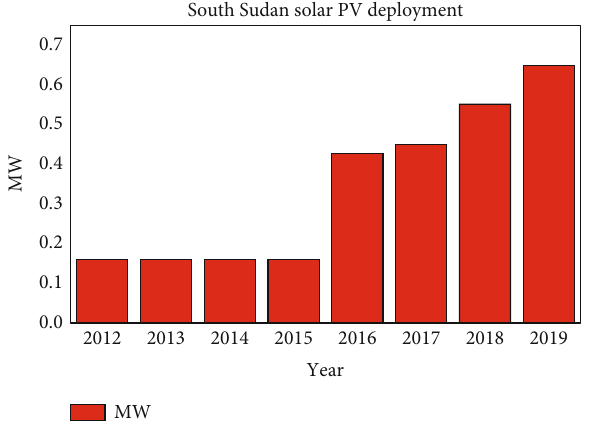
Figure 37: Solar PV trends in South Sudan by